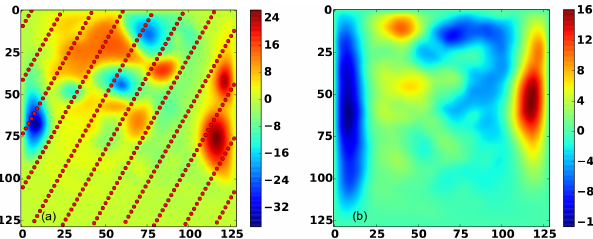
Figure 9. Running the filtering experiment.